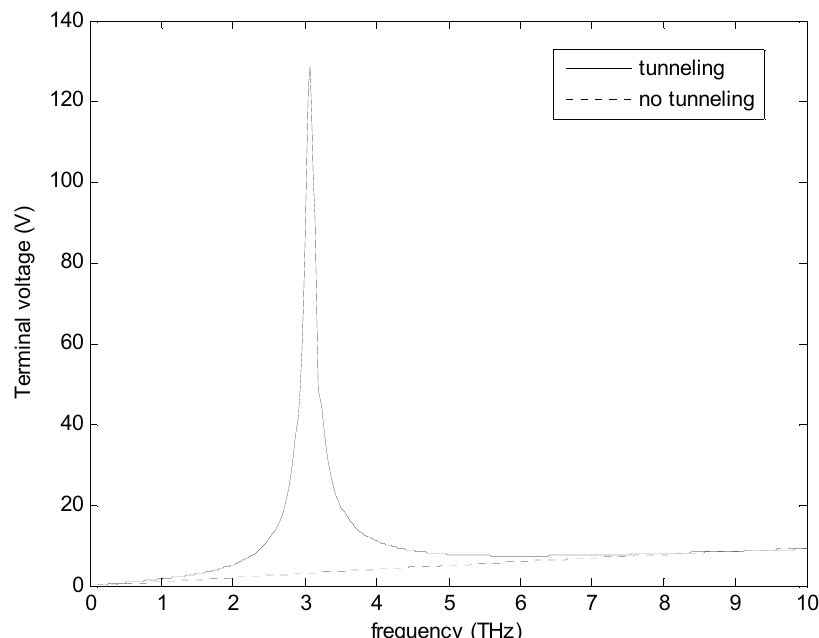
Figure 7. Terminal voltages at the ends of GNR contacts (see Figure 1a) illuminated by an external field, as a function of its frequency.